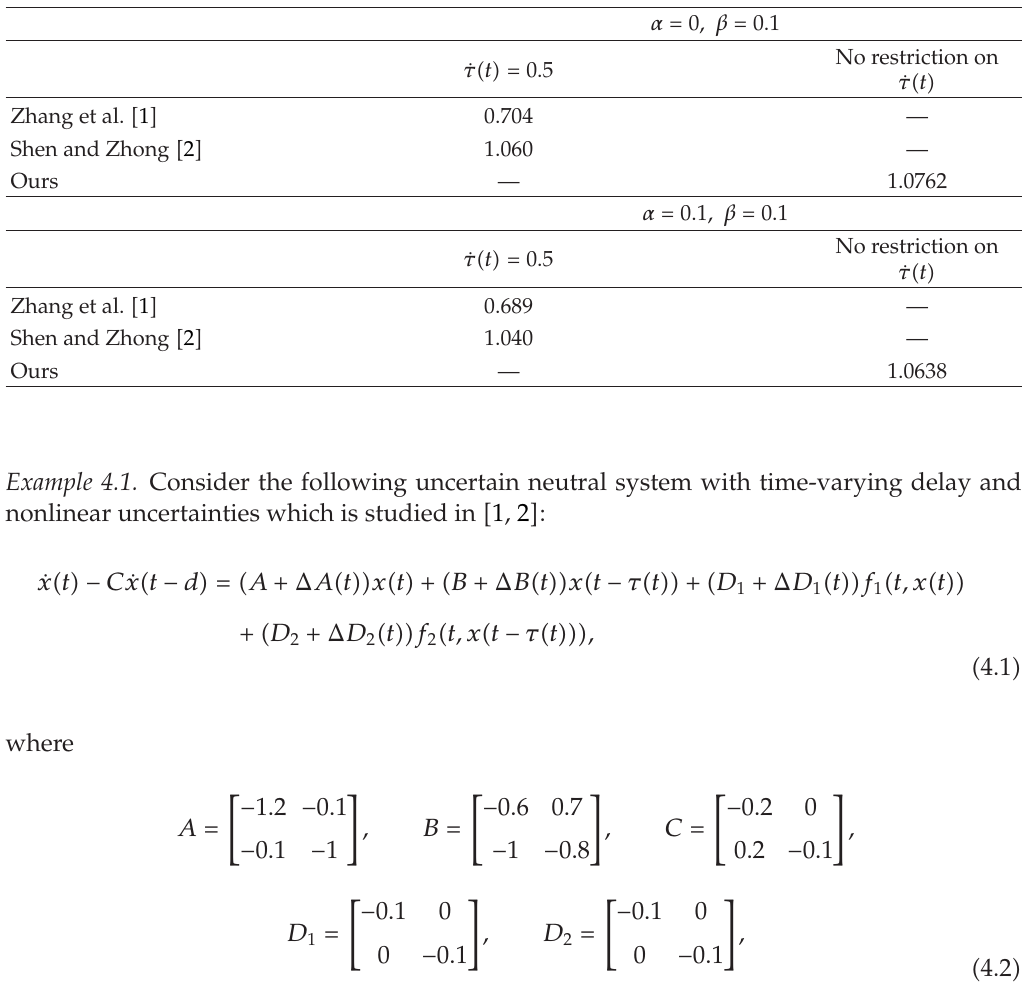
Table 1: Comparison of the maximum value τ M for γ (cid:9) 0 .